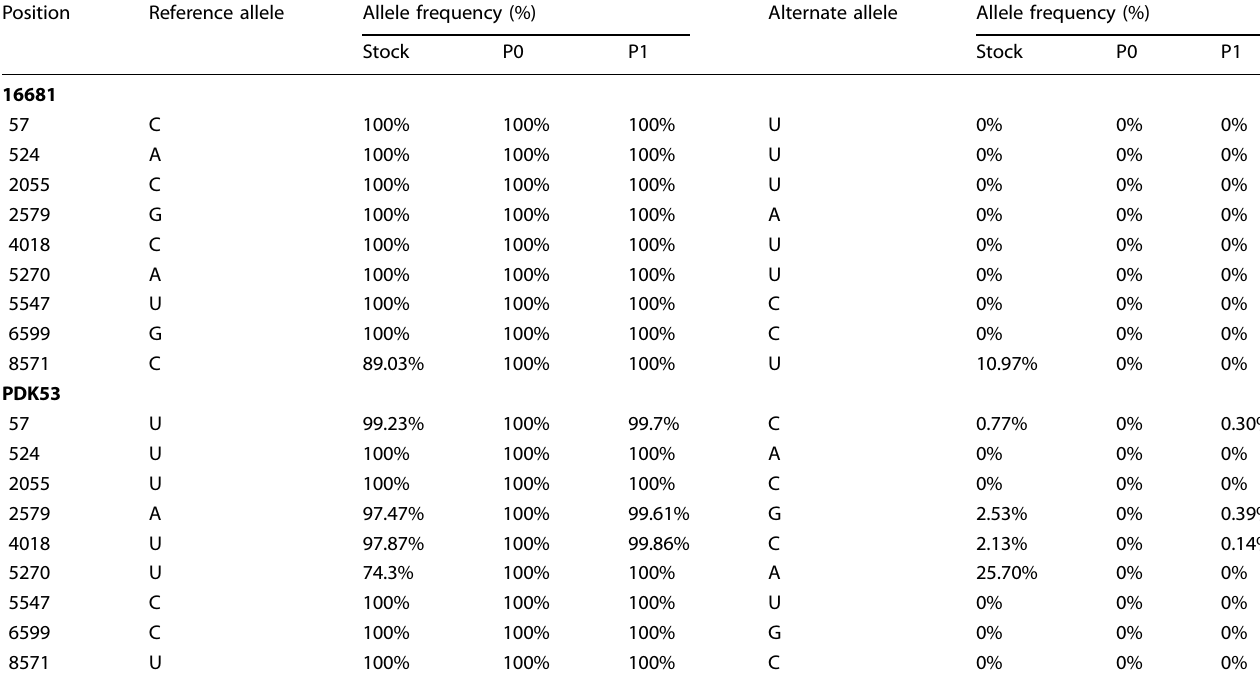
Table 1. Allele frequency at the 9 nucleotide positions that differentiate DENV2 16681 from PDK53. Position Reference allele Allele frequency (%) Alternate